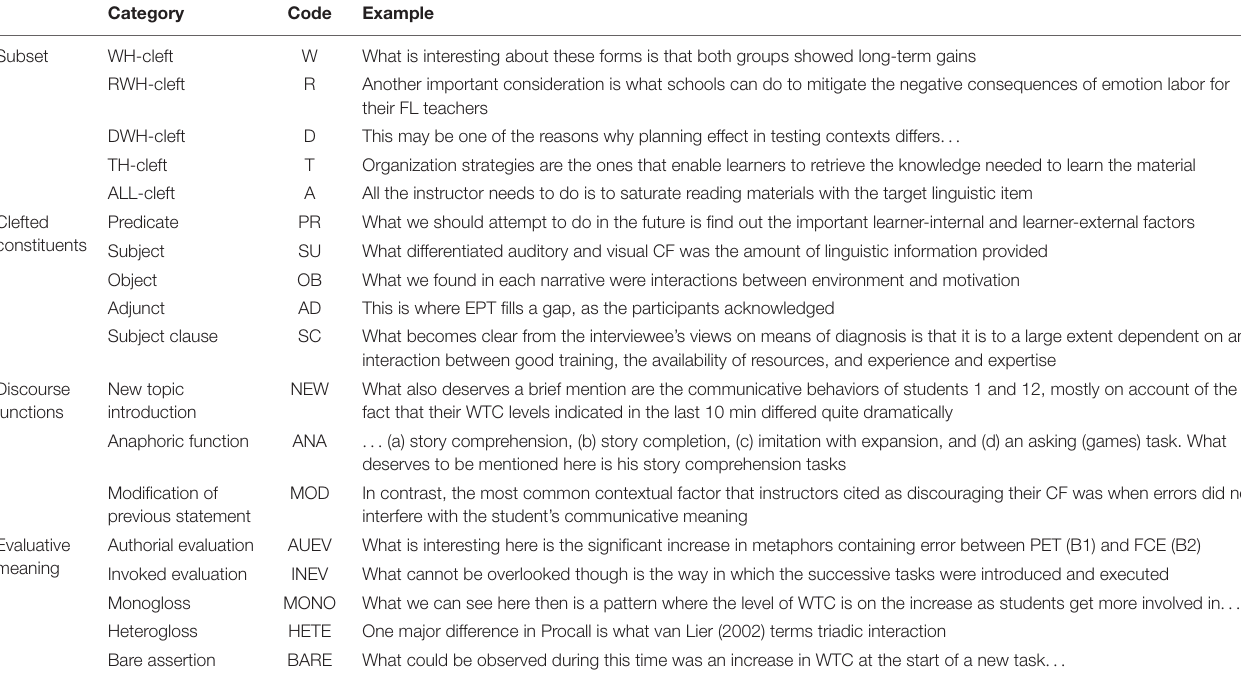
TABLE 1 | Coding system of pseudo-clefts.